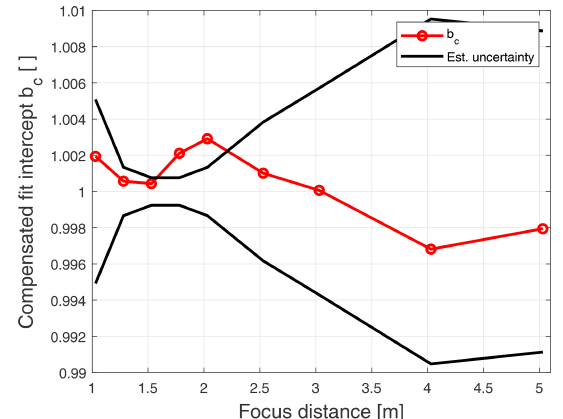
Figure 12. Compensated regression intercepts together with the es- timated standard